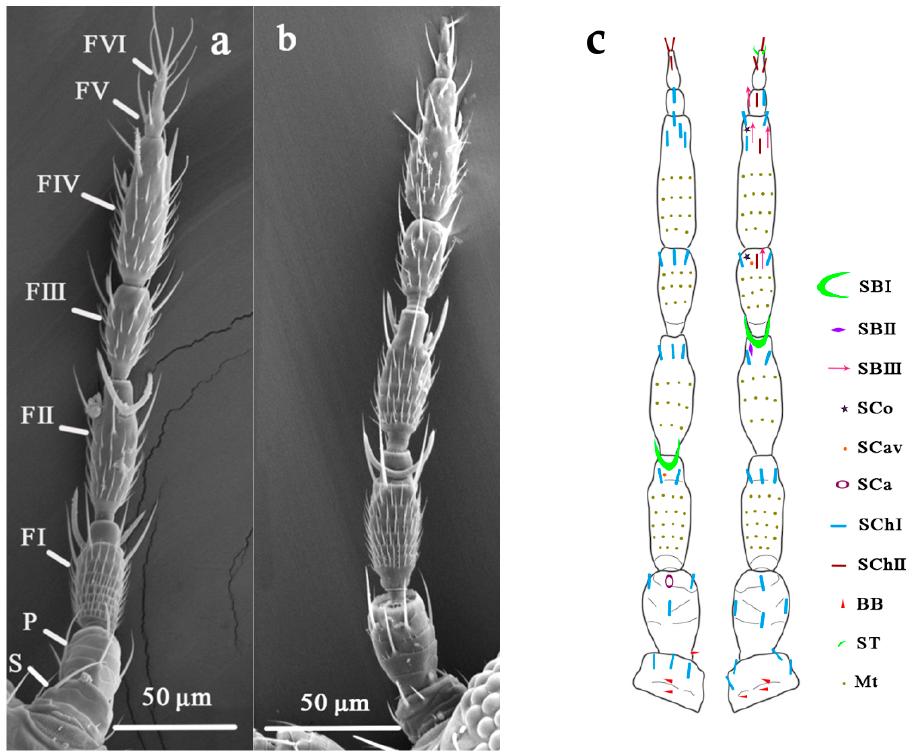
Figure 1. An overview of the general morphology and sensilla distribution on the thrip antennae. ( a ) ventral view of an O. loti antenna under SEM; ( b ) dorsal view of an O. loti antenna under SEM; ( c ) the schematic distribution of various types of sensilla on the dorsal (left) and ventral (right) side of three thrip species investigated. S: Scape. P: Pedicel. FI-VI: Flagellum I-VI. SBI-III: sensilla basiconica I-III. SCo: sensilla coeloconica. SCav: sensilla cavity. SCa: sensilla campaniformia. SChI, II: sensilla